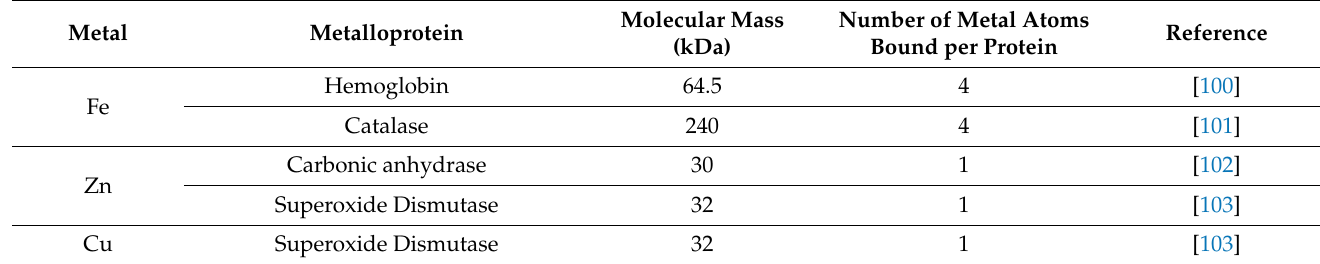
Table 2. Characteristics of major metalloproteins in red blood cell